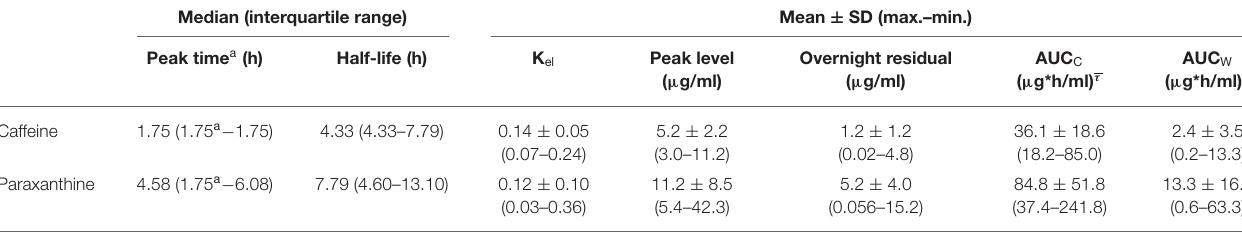
TABLE 1 | Peak level, peak time, half-life, and morning residuals of caffeine and paraxanthine during the caffeine condition. Median (interquartile range) Mean ± SD (max.–min.)